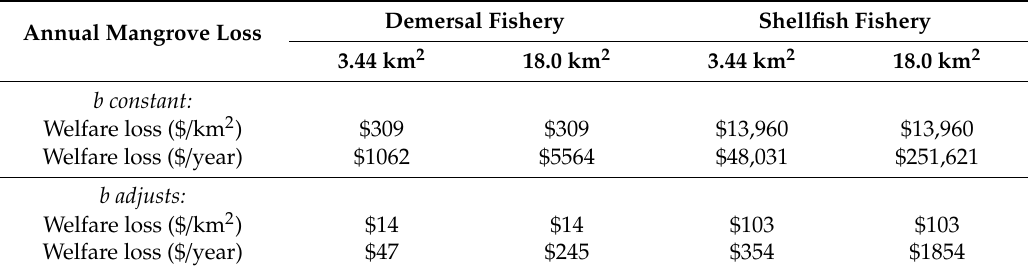
Table 3. Valuation of mangrove-fishery linkages under regulated open access,